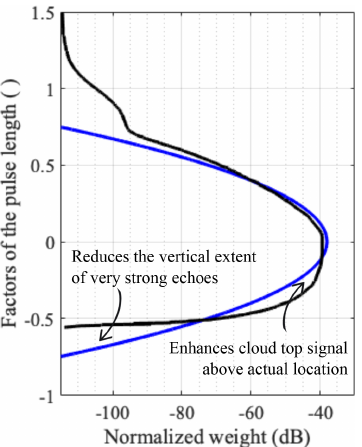
Figure 2. Symmetrical (blue) and asymmetrical (black) range- weighting functions for the forward-simulated radar architectures detailed in Table 1. Negative values are associated with the leading edge of the pulse in the direction of propagation.